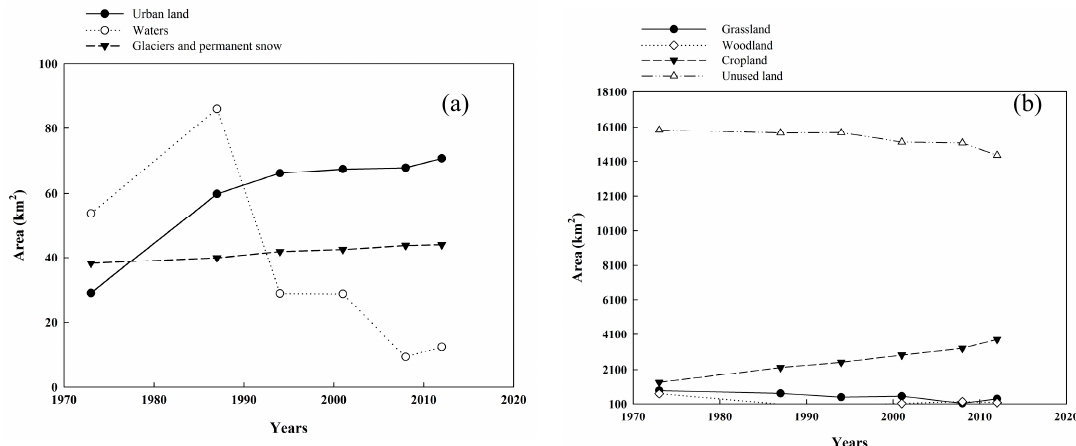
Figure 2. The area of urban land, waters, glaciers and permanent snow ( a ) and grassland, woodland, cropland, and unused land ( b ) in 1973, 1987, 1994, 2001, 2008 and 2012, respectively.